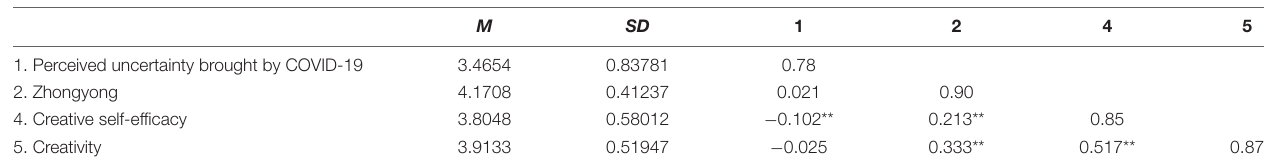
TABLE 2 | Descriptive statistics and correlations among variables.